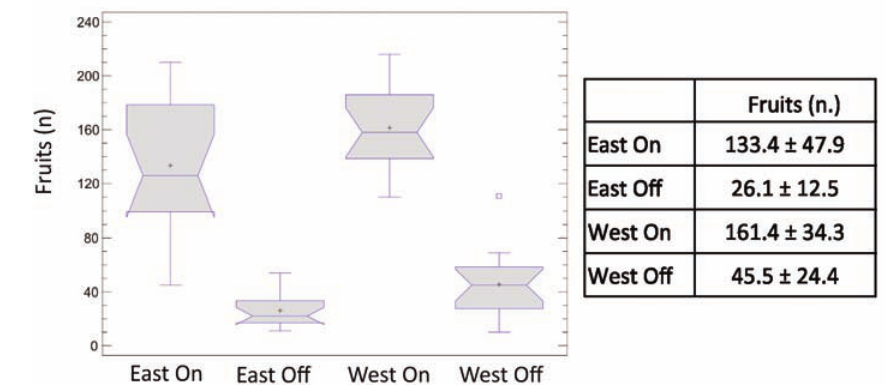
Fig. 4 - Score plot of PLS-DA model and summary statistics for the cv. Arbequina samples in the three different zones after the pruning, based on the measured vegetative growth parameters: 0) Air Off (Red), 1) Air On (Blue).